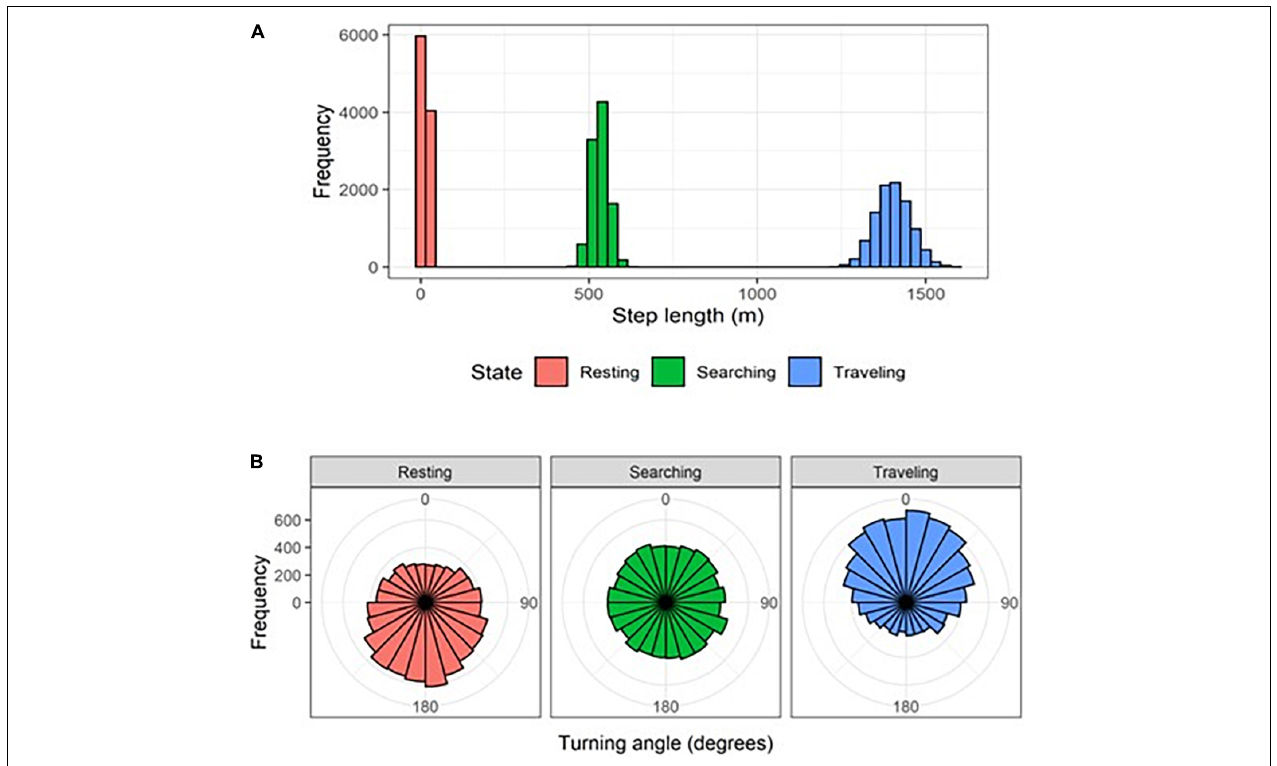
FIGURE 3 | Distributions of (A) step lengths and (B) turning angles for striped hyenas in the Central District of Israel in three behavioral states identified using a Hidden-Markov